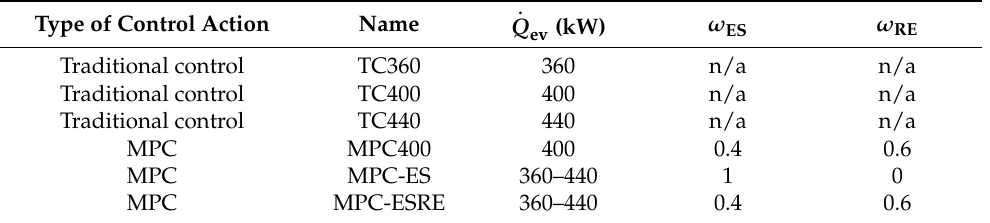
Table 3. Characteristics of the simulated scenarios within the multi-objective case study. (n/a = not